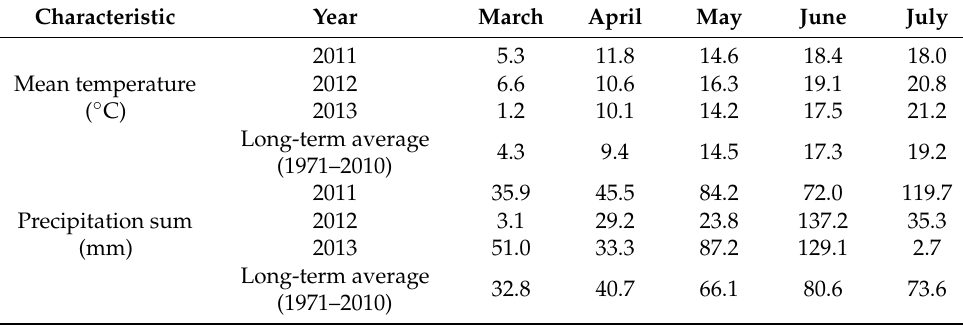
Table 1. Mean daily temperatures and monthly precipitation sums for vegetation period in 2011–2013 and comparison to long-term average values for the period 1971–2010.